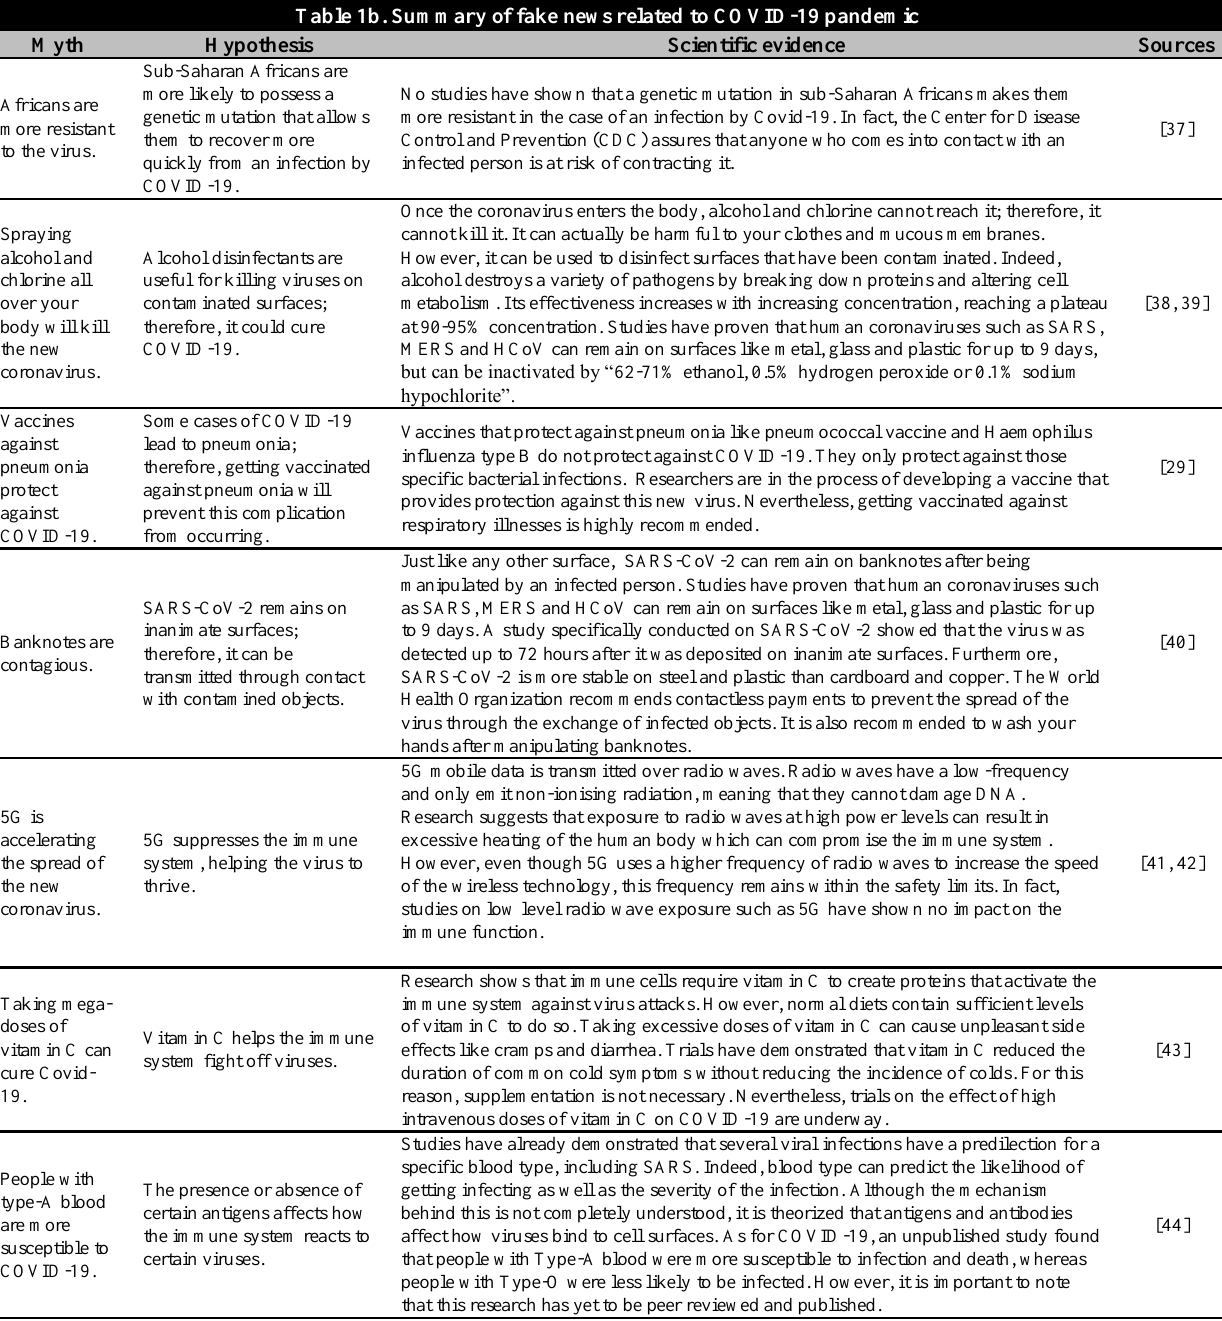
Table 1b. Summary of fake news related to COVID-19 pandemic Myth Hypothesis Scientific evidence